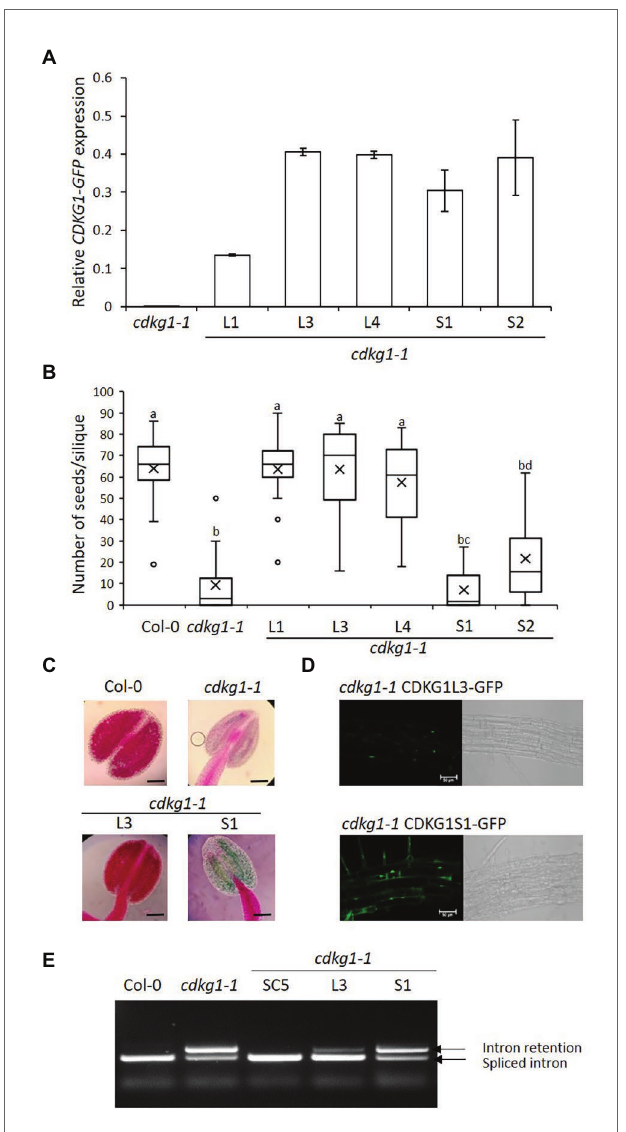
FIGURE 3 | The L but not the S form of CDKG1 can rescue the cdkg1-1 mutant phenotype. (A) Expression levels of the CDKG1L-GFP and CDKG1S-GFP transcripts as detected by qPCR in young inflorescences. Three independent lines expressing CDKG1L-GFP and two lines expressing CDKG1S-GFP in a cdkg1-1 background were tested. The cdkg1-1 mutant was used as a control. (B) Fertility counts of the transformed plants. The average number of seeds per silique was determined for Col-0, cdkg1-1 , and lines expressing CDKG1L-GFP and CDKG1S-GFP under the control of the CDKG1 promoter in a cdkg1-1 mutant background. Data represent average and the interquartile range for 30 siliques from three plants. Superscript letters represent significance groups for p < 0.001. (C) Pollen viability staining of the lines above. Round carmine-colored pollen grains are viable, while white/blue shrunken pollen is not viable. Scale bar = 100 μ m. (D) The CDKG1L-GFP protein localizes to the nucleus of root cells, while the CDKG1S-GFP protein can be found both in the nucleus and in the cytoplasm of root cells in plants grown at 23 ° C. Images are single confocal sections acquired using the same settings. The GFP channel (green) and a bright field image are shown. Scale bar = 50 μ m. (E) Splicing profile of the CalS5 mRNA in young inflorescences of the different mutants. In the wild type Col-0 only the fully spliced form is observed, while in the cdkg1-1 mutant, both spliced and intron retention forms are